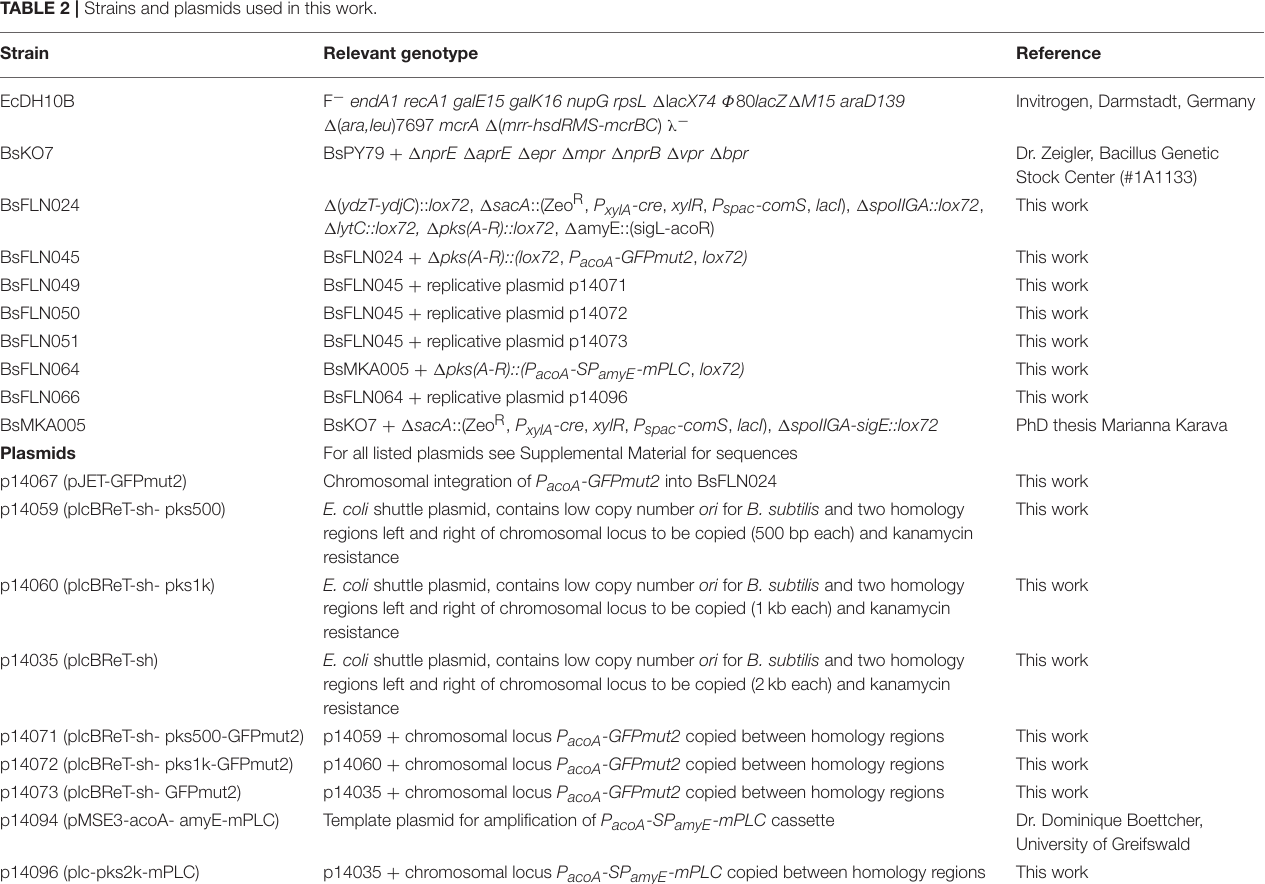
TABLE 2 | Strains and plasmids used in this work. Strain Relevant genotype